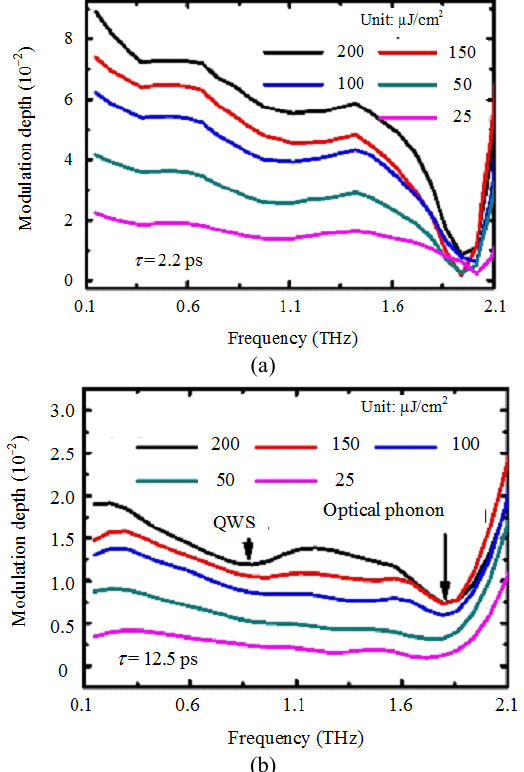
Fig. 4 Corresponding frequency-resolved THz transmission spectra of Fig. 3 at the time delay of: (a) 2.2 ps and (b) 12.5 ps, calculated by the FFT method. Here, two resonant absorption features at 0.9 THz and 1.9 THz are observed, which are caused by the quantum well state (QWS) and optical phonon,